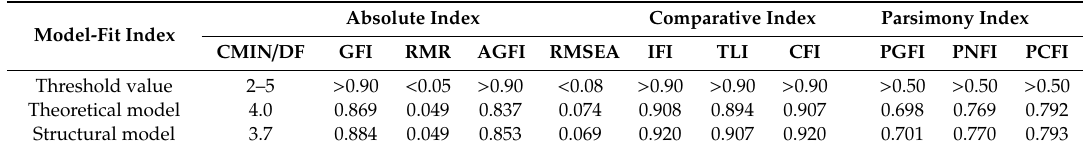
Table 5. Goodness-of-fit indices.